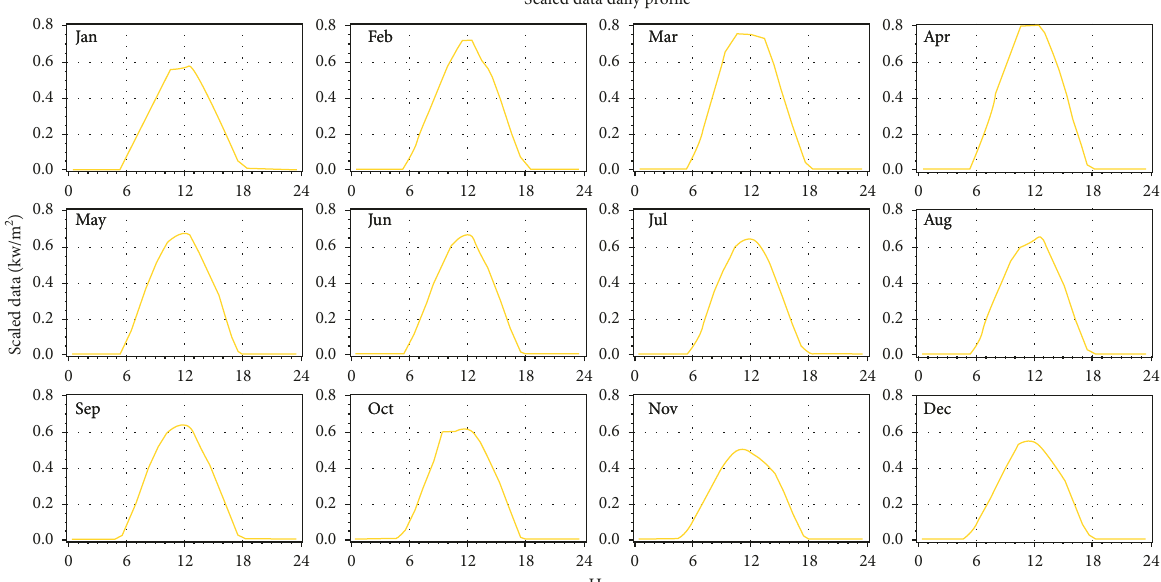
Figure 17: Details of solar radiation on horizontal surfaces in Magelang district, Central Java province, Indonesia.